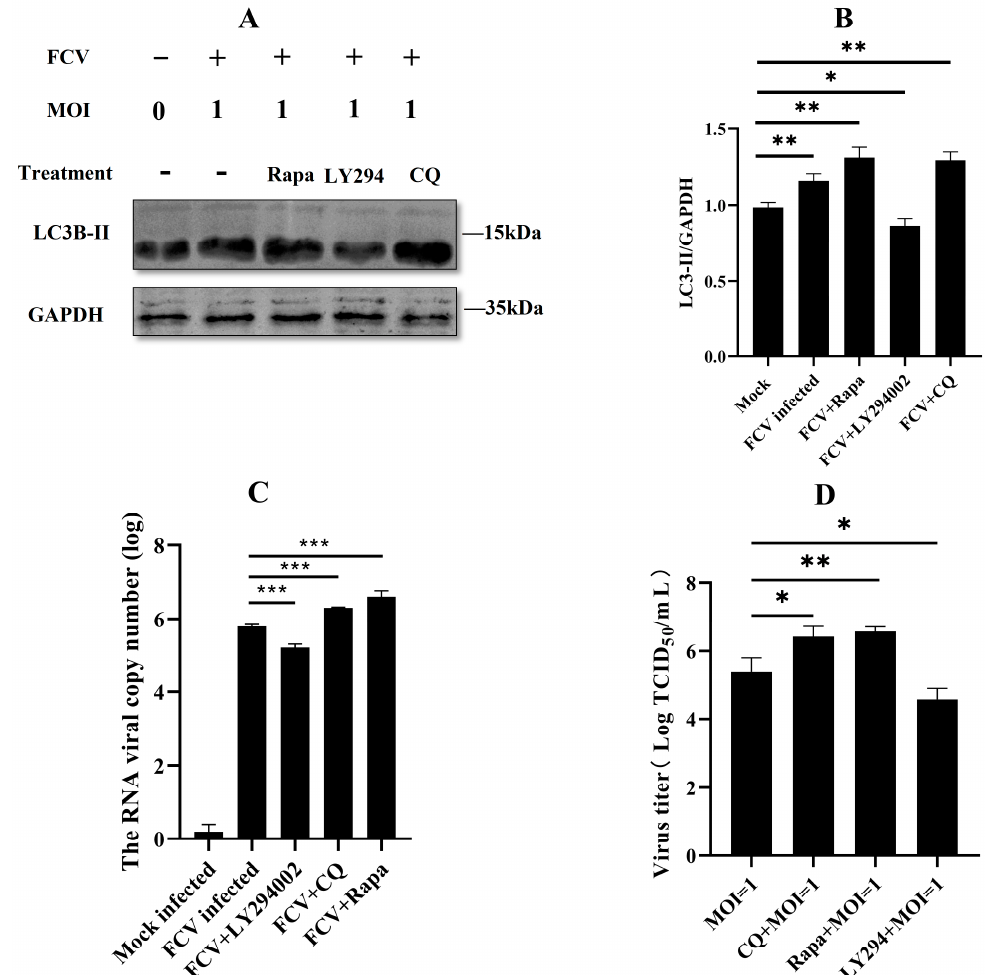
Figure 3. Autophagy promoted feline calicivirus replication. ( A ) Cells were treated with rapamycin (1 µ M), ly294002 (20 µ M), and chloroquine (50 µ M) for 24 h, then CRFK cells were infected with FCV-SCAU-10. Protein band intensity of LC3B-II and GAPDH was used for Western blotting quantification analysis. Samples were analyzed in three independent experiments. ( B ) Protein band intensity of LC3B-II and GAPDH. ( C , D ) Supernatants were collected and subjected to TCID50 and qPCR. (* p < 0.05, ** p < 0.01, *** p < 0.001).